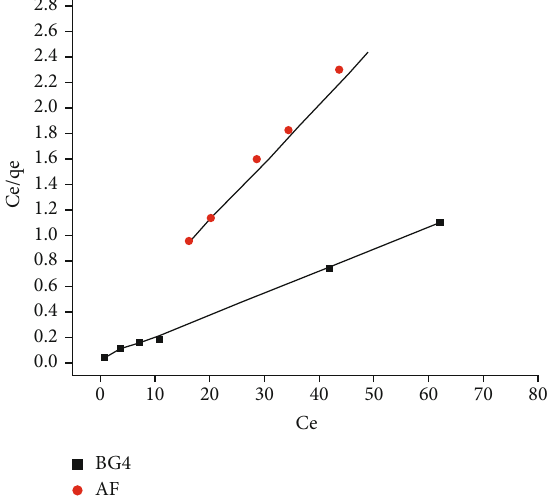
Figure 11: Freundlich plot of BG4 and AF adsorption onto HUAC.